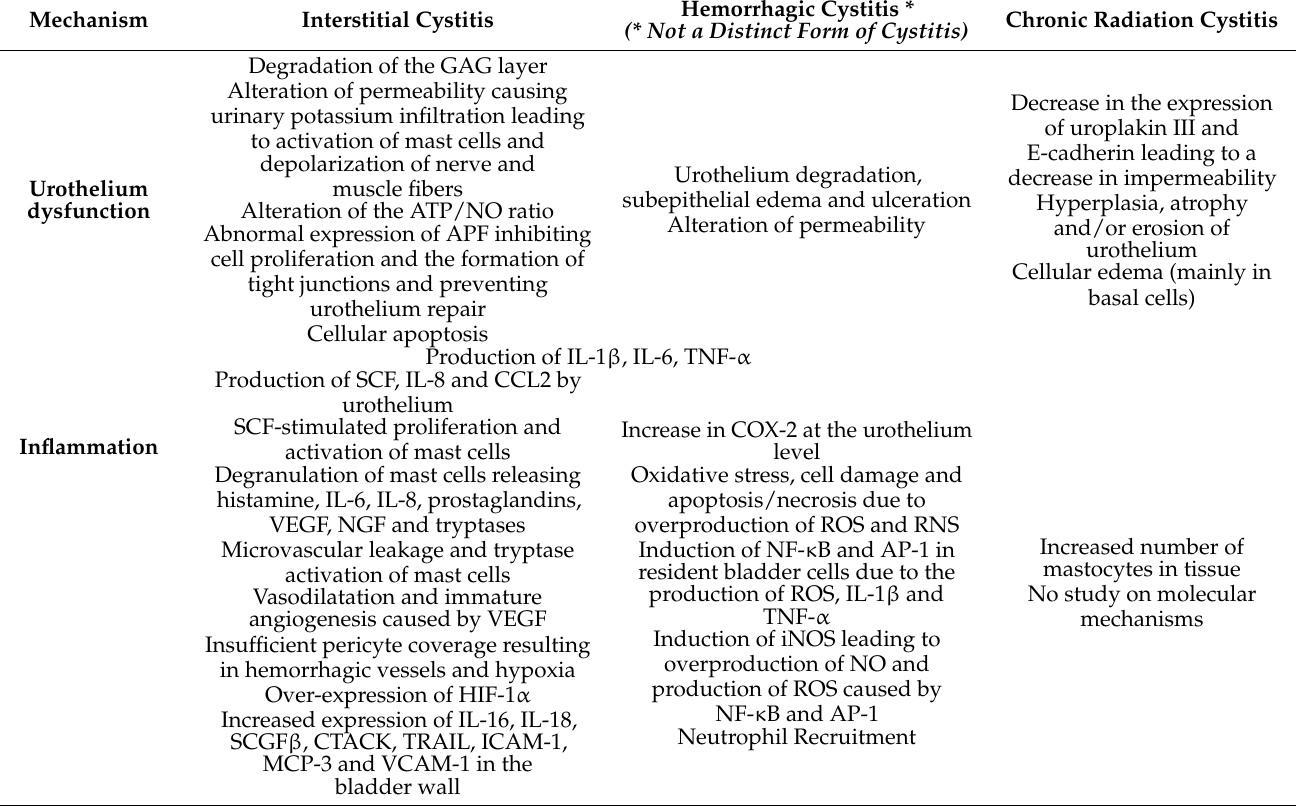
Table 2. Pathophysiological mechanisms: Urothelium dysfunction and